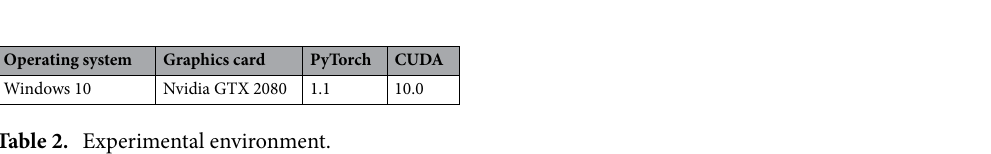
Figure 5. The change trend of learning rate using cosine annealing with warm restart.